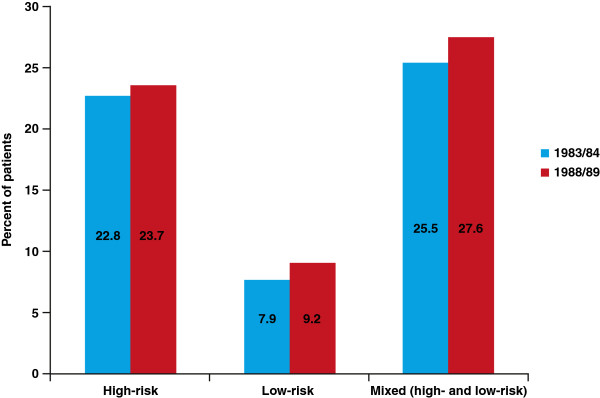
Positive HC2 test results for the 1983/84 and 1988/89 cohorts.